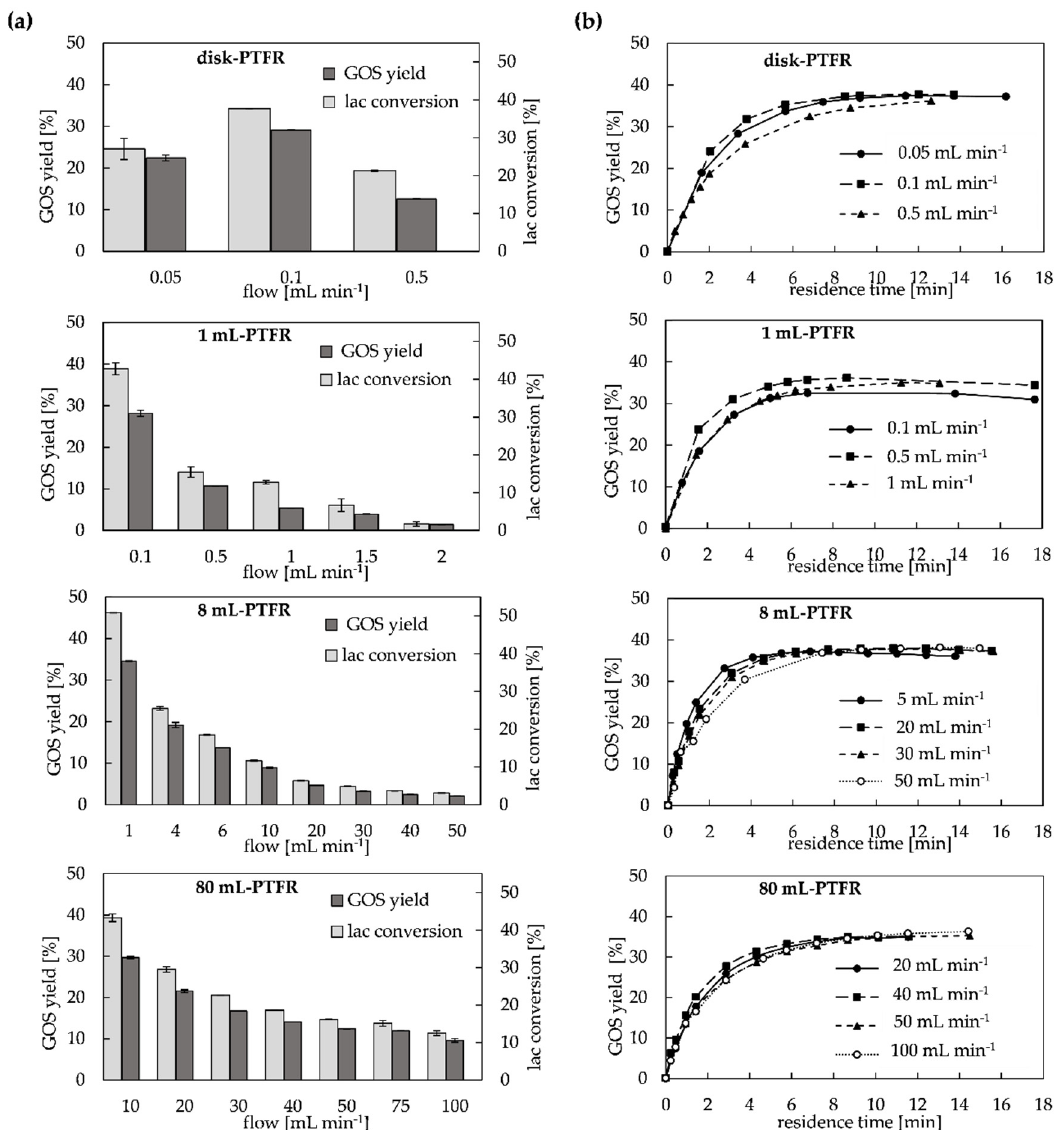
Figure 3. Performance of monolithic PTFRs (disk, 1 mL, 8 mL and 80 mL): ( a ) GOS yield and lactose conversion for the continuous configuration depending on the flow (ILC = 100 g L − 1 ); ( b ): GOS yield based on residence time (ILC = 100 g L − 1 ).